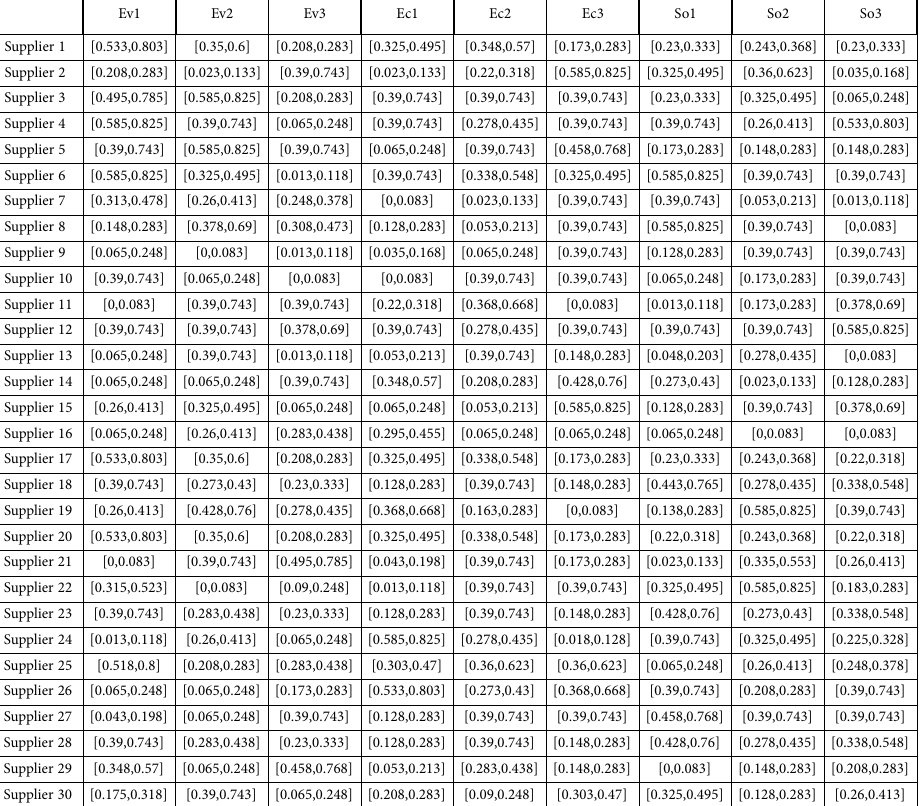
Table 7. Unadjusted aggregate grey scores of suppliers on sustainability factors ( ij v ⊗